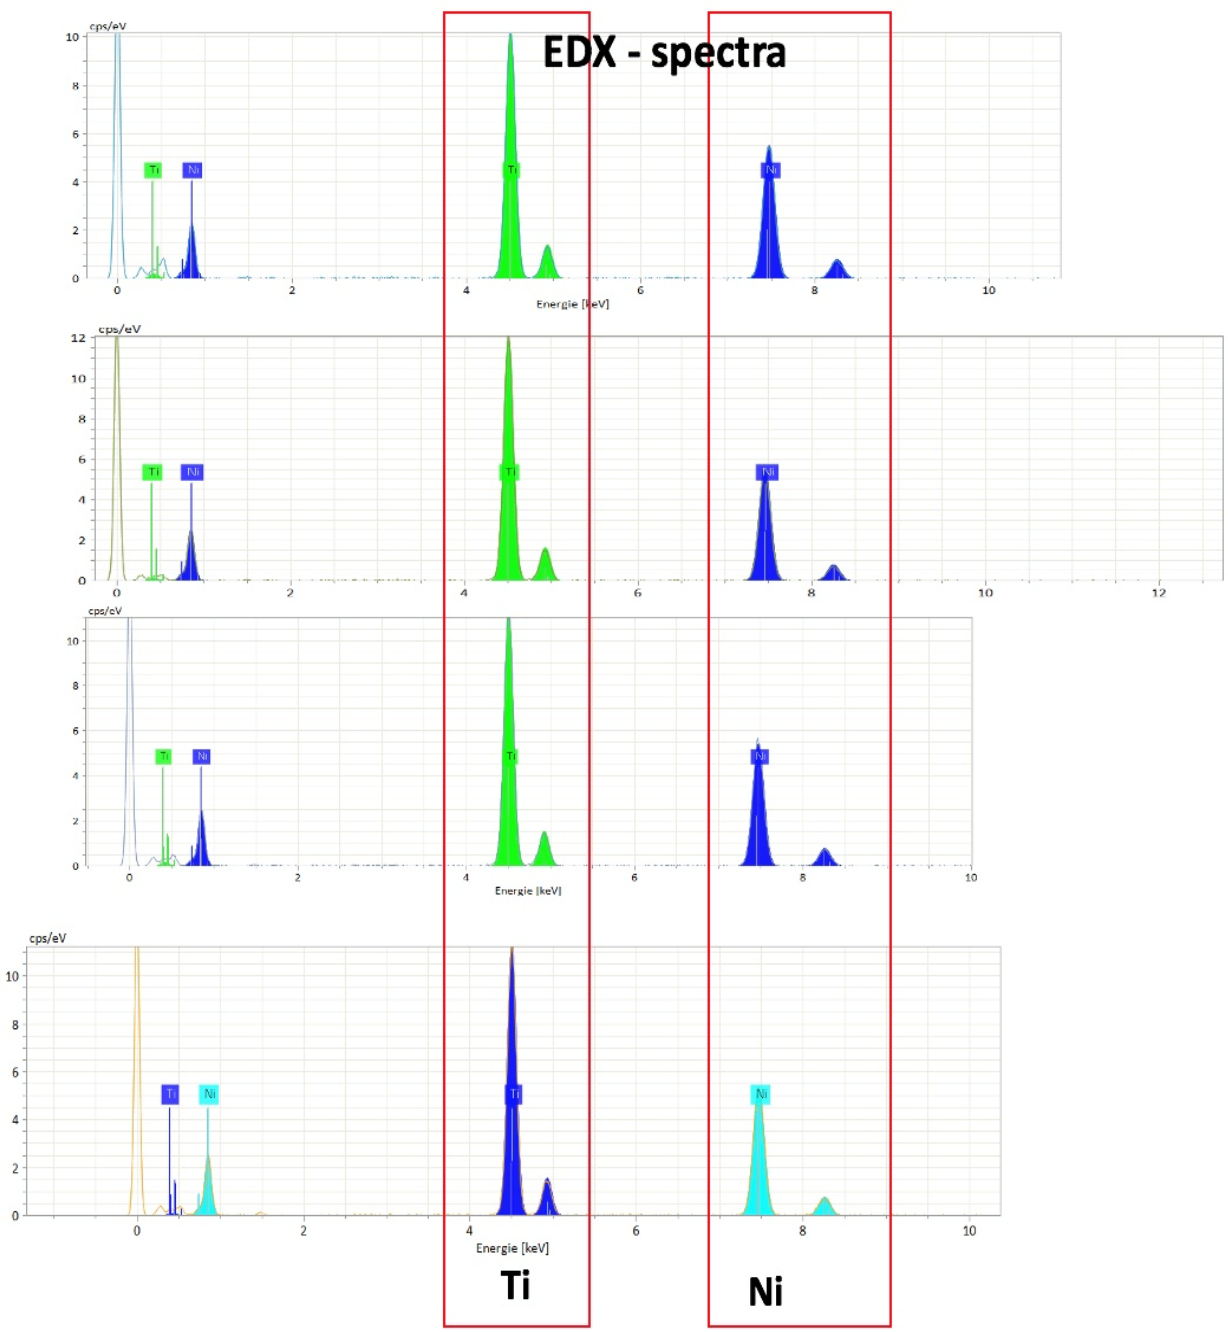
Figure 6. Results from the EDX analysis at four different areas at 20 keV, cps/eV vs. keV curves; EDX spectra of the four measurements.